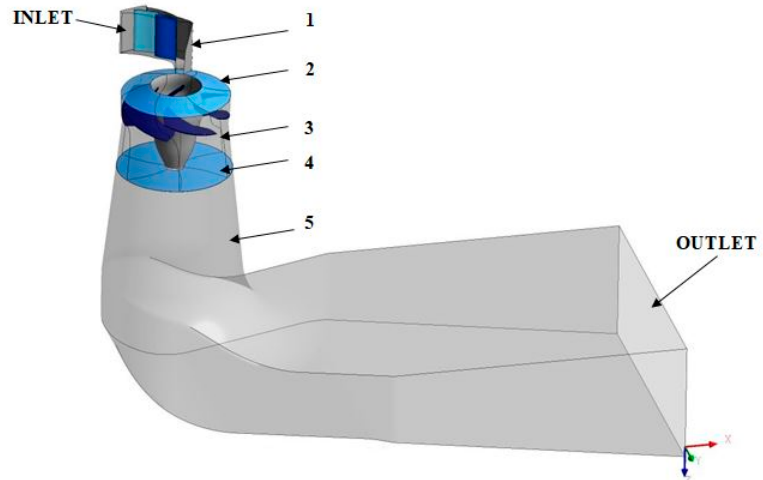
Figure 4. Computational domains and interfaces: 1. Guide vane and stay vane domain. 2. Guide vane–